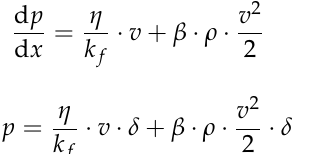
[19]. A small piece of a CU filter, approximately 5 × 12 × 1 mm 3 (h × l × w) in size, was